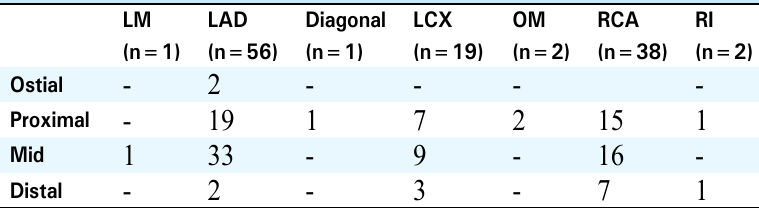
Table 2. Culprit lesion stenting details.